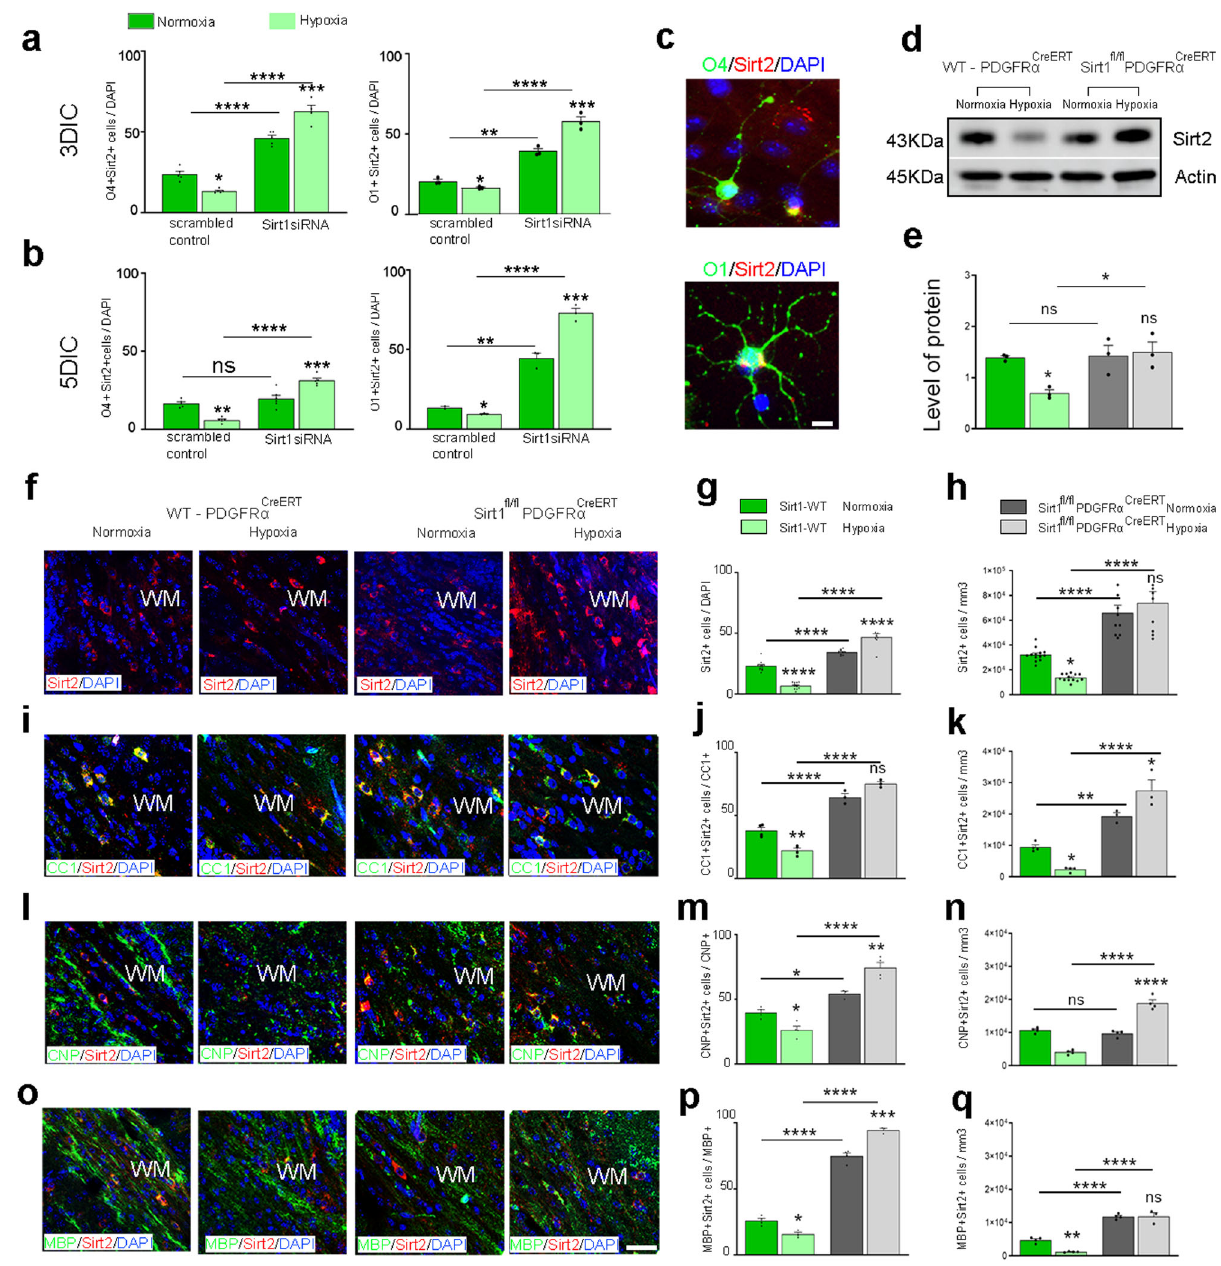
(** p =0.0017, * p =0.014, # p =0.059 Student ’ s t test, n =4 Nx and Hx samples). j VisualizationofSirt2bindingingenomicregionupstreamof Diaph2 gene.Redbox highlights enriched binding in Hx. k RNAscope analysis of Diaph2 expression in Pdgfr α + OPCs (arrows) in the WM ofNxand HxWT miceatP22. Scalebars=10 µ m. l Quanti fi cation of the percentage of Diaph2 + OPCs in the WM of Nx and Hx WT miceatP22(*** p =0.0001, n =4NxandHxmice,Student ’ s t test). m Visualizationof Sirt2 binding in the genomic region upstream of Vegfc gene. Red box highlights enriched binding in Hx. n RNAscope analysis of Vegfc expression in Pdgfr α + OPCs (arrows) in the WM of Nx and Hx WT mice at P22. Scale bars=10 µ m. o Quanti fi cationofthepercentageof Vegfc + OPCsintheWMofNxandHxWTmice at P22 (**** p <0.0001, Student ’ s t test, n =4 Nx and Hx mice). Graphs display mean±SEM values.Allstatisticaltests aretwo-sided.Source dataare provided asa Source Data fi le. The schematic in e was created using CorelDraw 2018 software (version